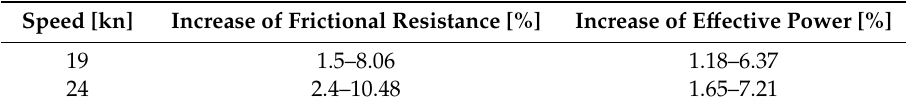
Table 7. Increase in resistance and e ff ective power depending on the type of AF coating and speed. Source: Adapted and modified on the basis of